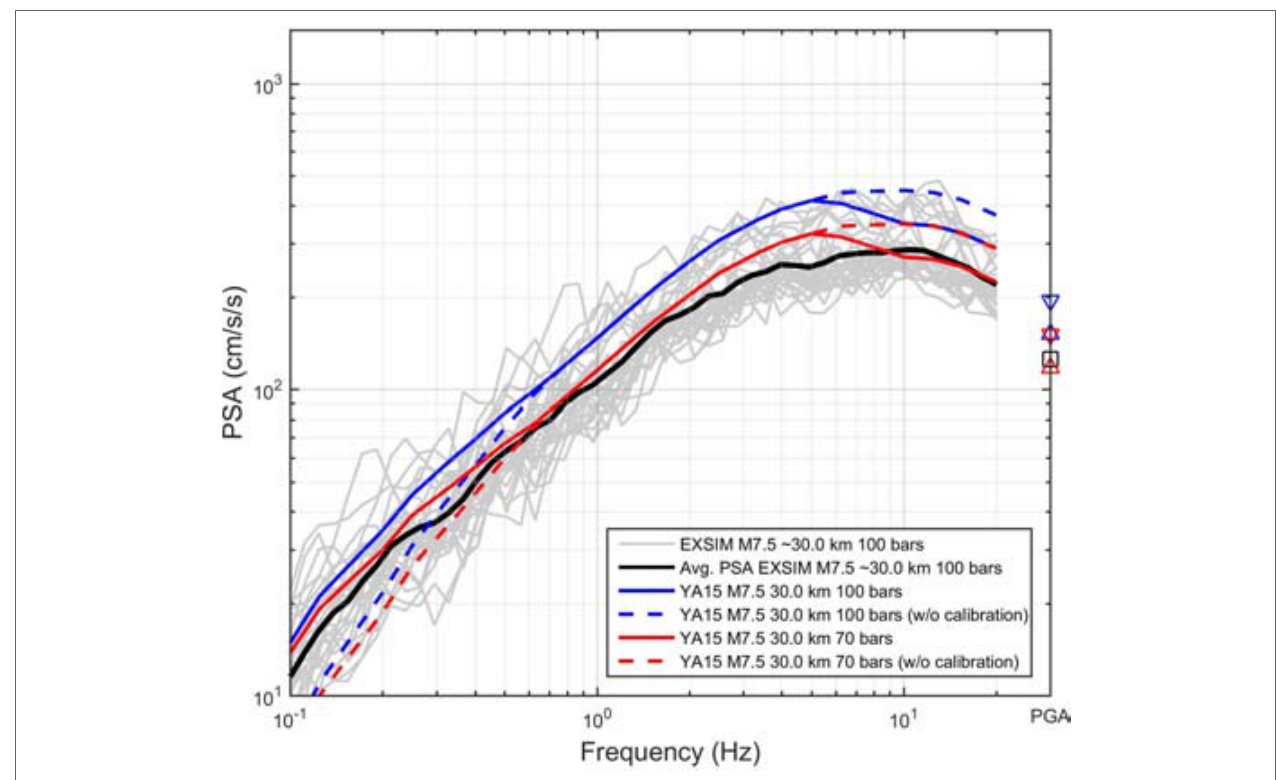
FIGURE 6 | Magnitude scaling at Rcd = 30km for an M 7.5 event. Black line is the mean of pseudospectral acceleration (PSA) for all stations at Rcd (cid:24) 30km (shown with gray lines). Solid Blue and red curves are YA15 model for stress parameter of 100 and 70bar (frequency-dependent calibration factor is included), respectively. Dashed blue and red lines represent YA15 without considering the calibration factor. Black square is the mean of simulated PGA for all stations at Rcd (cid:24) 30km, up and down blue triangle symbols are PGA based on YA15 models for stress parameter of 100 and 70bar, respectively, and up and down red triangle symbols are PGA based on YA15 models without considering the calibration